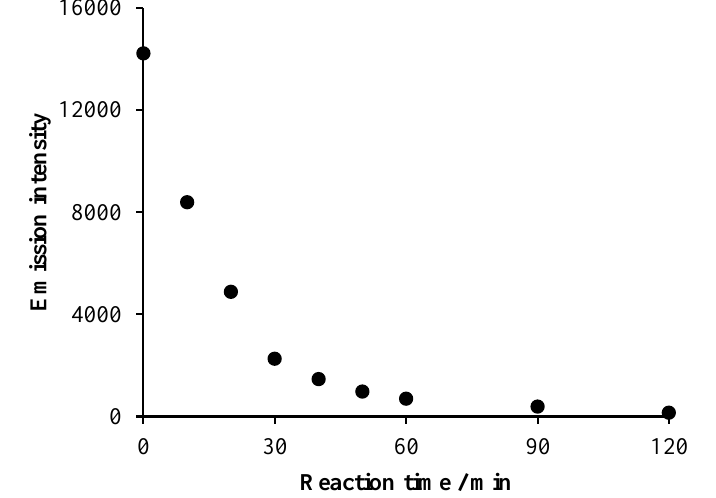
Figure 5. The change of the emission intensity (after removal of the suspended TiO 2 ) during the photocatalysis in the aerated system containing 2 × 10 −4 mol·dm −3 Triton X-100 and 1 g·dm −3 catalyst (ℓ = 1 cm, λ ex =277 nm, λ em =302